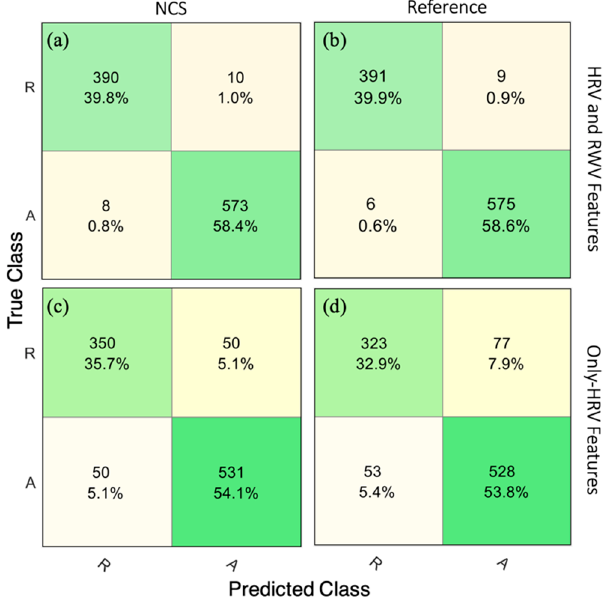
Figure 8. The 5-fold CV confusion matrices showing relaxed–inattention (R) and attention (A) clas- sification by the kNN algorithm using NCS and reference HRV and RWV features in ( a , b ), and only HRV features in ( c , d ), respectively. The cells list number of epochs in each category and their overall percentage.